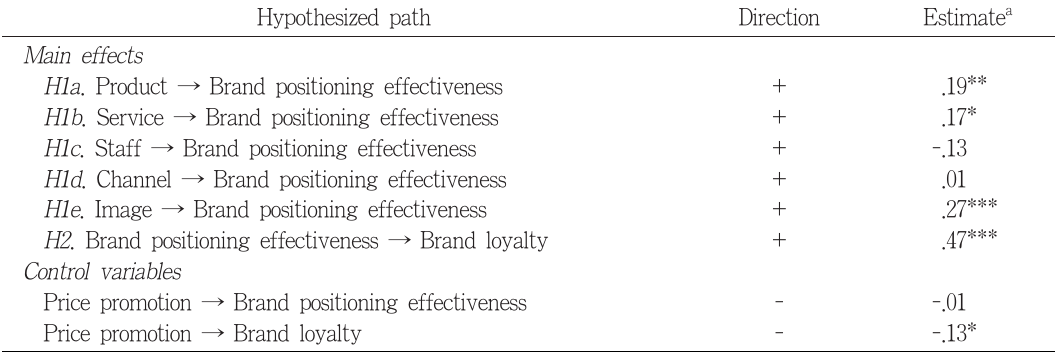
<TABLE 4> Path Analysis Results for Main